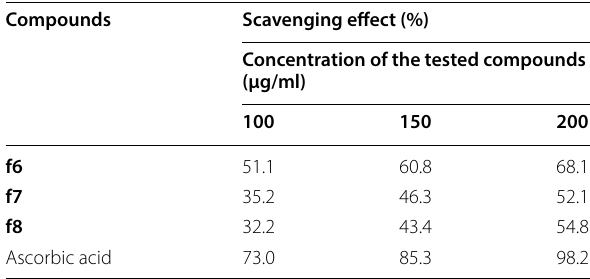
Table 46 DPPH radical scavenging activity of the tested compounds Compounds